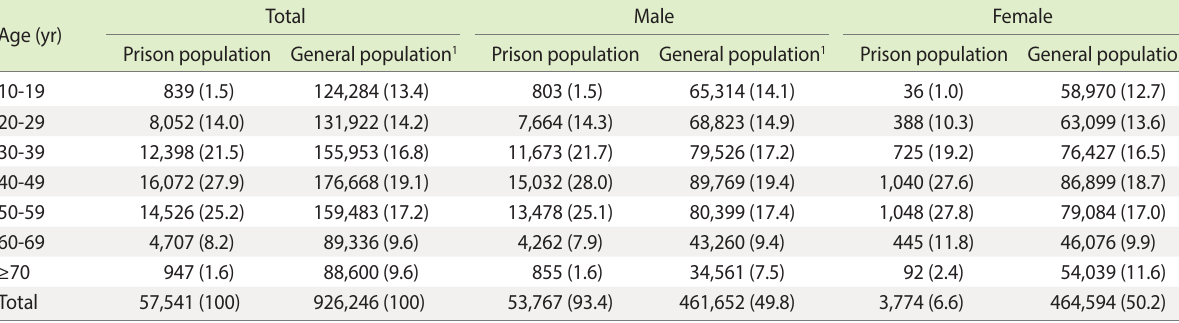
Table 1. Age distribution of study population by sex Total Male Age (yr) Prison population General population